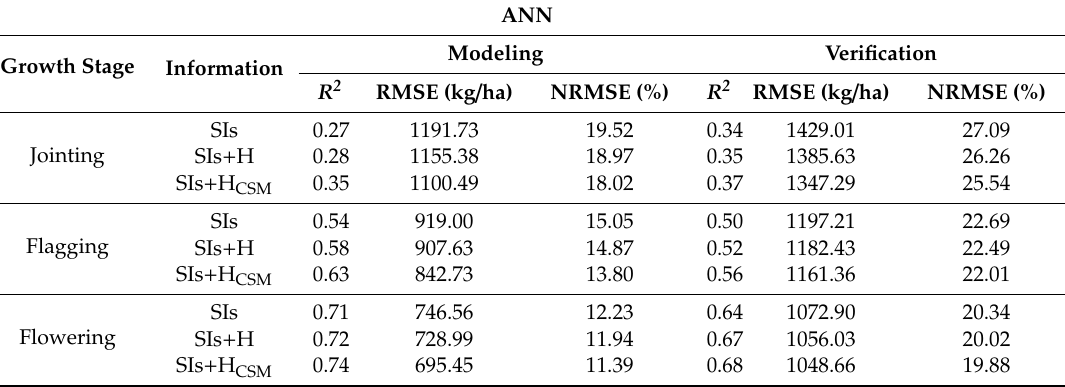
Table 5. Results of the estimation of the yield of winter wheat in di ff erent growth stages by using an artificial neural network (ANN).